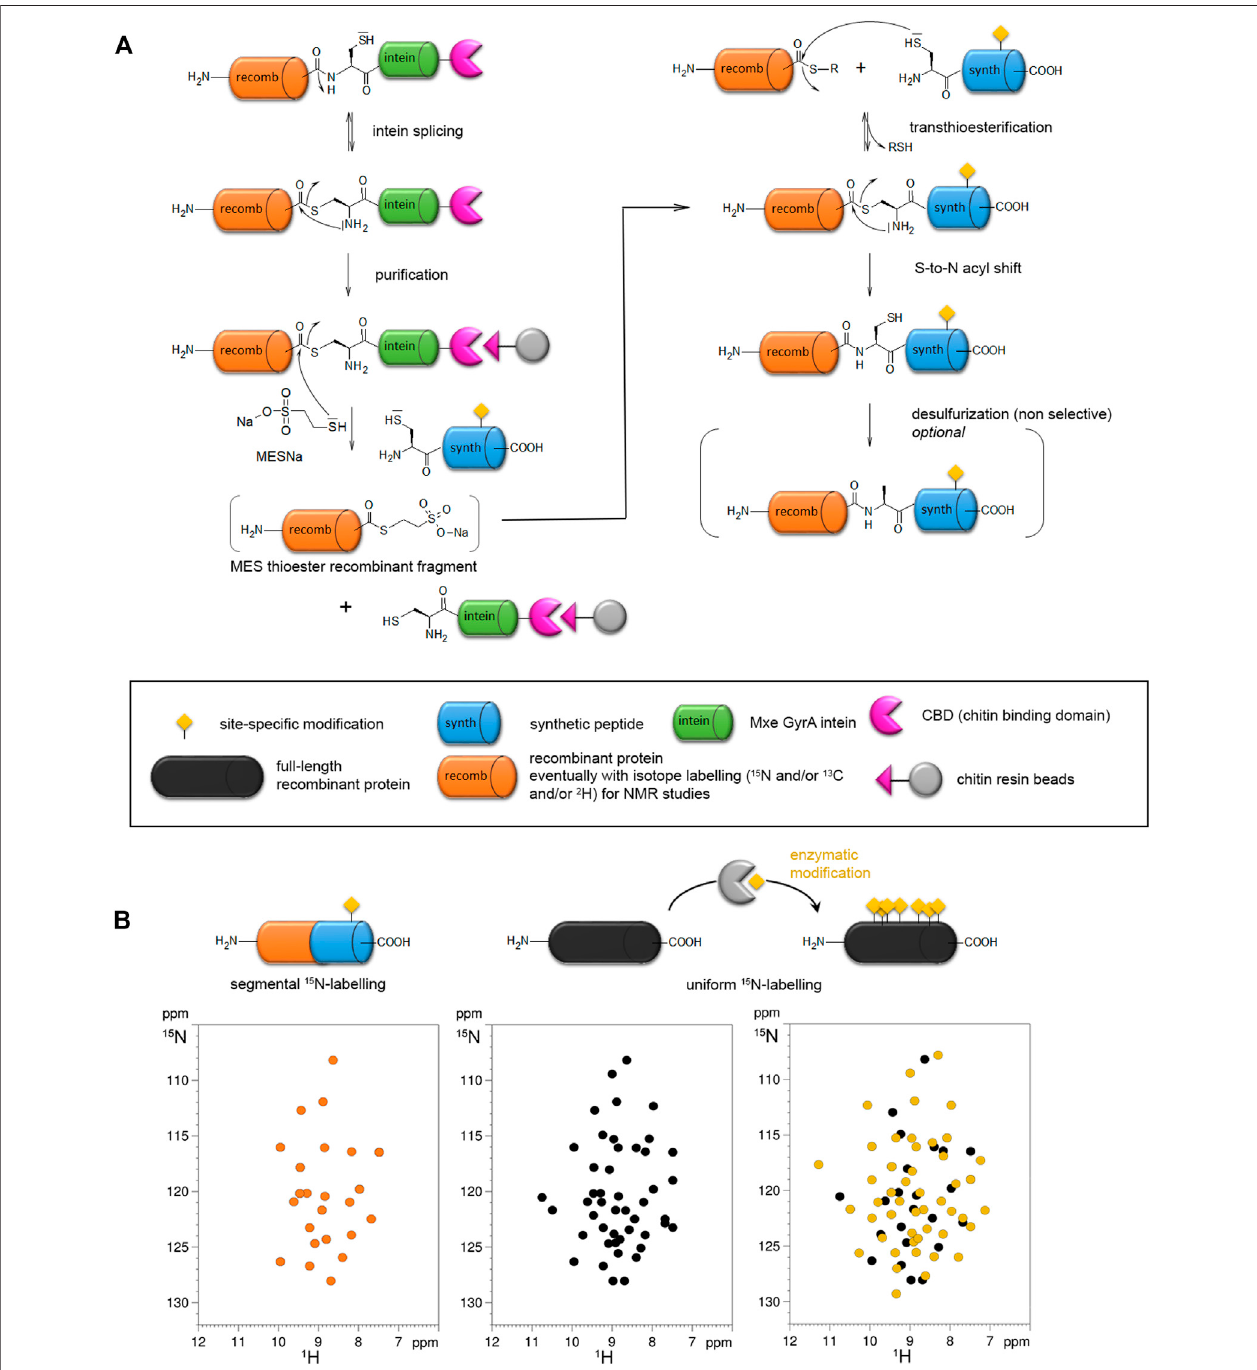
FIGURE 3 | Expressed protein ligation (EPL) strategy for site-speci fi c modi fi cation of proteins (A) and segmental isotope labeling for NMR studies (B) . (A) The synthetic peptide (blue) incorporating a site-speci fi c modi fi cation (yellow) is obtained by SPPS and ligated to a recombinant protein fragment (orange) expressed in a heterologoussystemwhich caneventuallybeisotopicallylabeledforNMR study.The recombinantprotein canbeexpressed asinteinfusionprotein (inteinin green) with aCBDtag(pink)forpuri fi cation onchitinbeads. Thereaction withsodium2-mercaptoethane sulfonate(MESNa)andasyntheticpeptidewithaN-terminal cysteine leads to a semisynthetic protein. (B) In the NMR 1 H- 15 N HSQC spectrum, only the 15 N-labeled region of the protein is visible, therefore the synthetic region bearing the modi fi cation is invisible (orange spectrum). This strategy called segmental isotopic labeling allows a reduction of NMR signals in the spectrum relative to the full-length, uniformly labeled protein (black) without PTM (black spectrum) or with enzymatically installed PTMs (yellow spectrum). It is noteworthy that modi fi cations of protein resonancesobservedlocallyforthemodi fi edresiduesanditsneighborsintheprimarysequenceintheuniformlylabeledproteincannotbeobservedinthesemisynthetic protein with segmental labeling due to the absence of isotopic labeling in the region of PTM. However, this modi fi cation may have a long-range structural impact on residues of the 15 N-labeled fragment due to conformational proximity that can be detected through perturbations of signals in the isotopically labeled region.